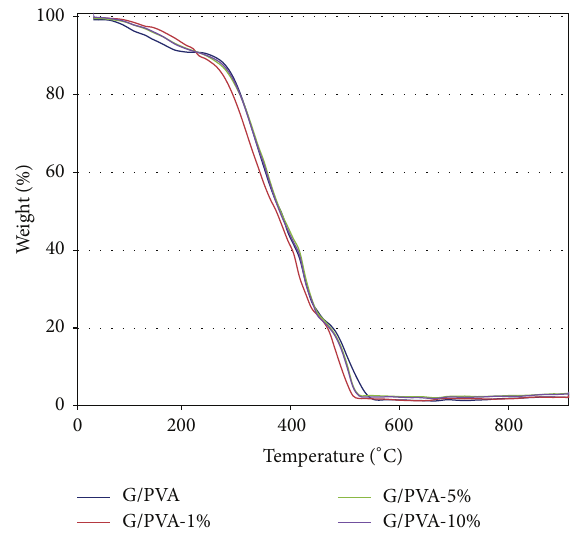
Figure5:ThermogravimetricanalysisresultsofG/PVA,G/PVA-(1% biocide), G/PVA-(5% biocide), and G/PVA-(10% biocide). The data were obtained under compressed air at 10 ∘